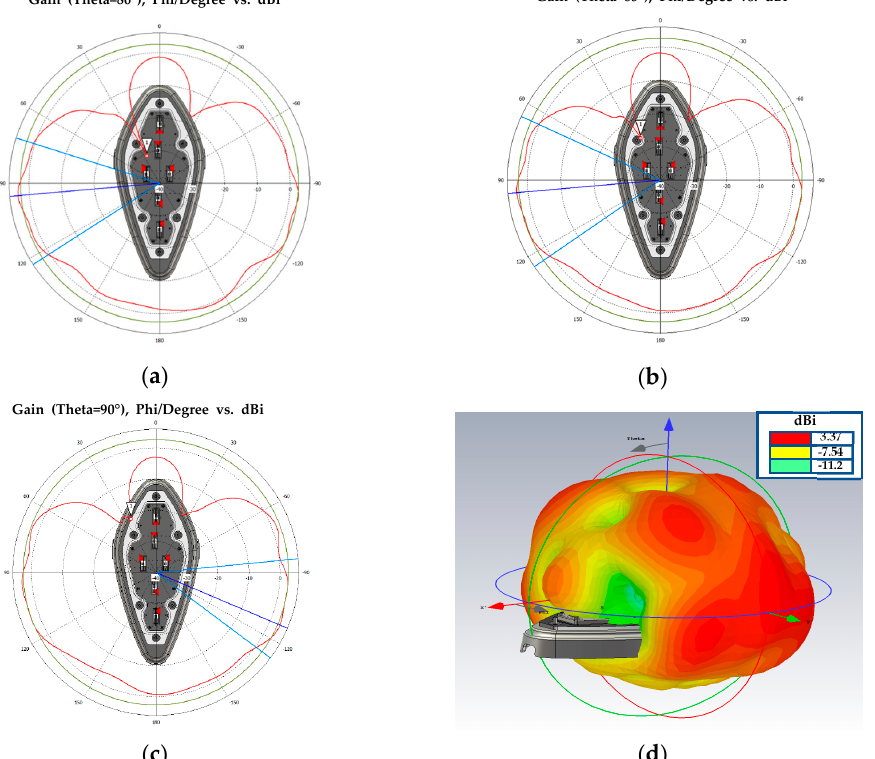
Figure 5. Radiated beam patterns obtained from the monopole-only WAVE antenna on the shark-fin module at the angles of ( a ) 80°, ( b ) 85°, and ( c ) 90°; and ( d ) 3D view. Conversely, the 2D- and 3D-radiated beam patterns from the monopole WAVE antenna with quadruple closed-loop devices on the shark-fin module (in Figure 1c) are shown in Figure 6. The 2D null value comparison of monopole-only (red color) and monopole with quadruple closed-loop devices (green color) at angles of 80°, 85°, and 90°, respectively, is shown in Figure 7a–c. At 80°, the null value is enhanced from − 30.8 to − 4.7 dBi. At 85°, the null value is enhanced from − 26 to − 5.5 dBi, and at 90°, the null value is enhanced from − 21 to − 6 dBi. From these simulation results, the monopole-only antenna has a serious null point when installed on the shark-fin module. However, the proposed antenna, a monopole with a closed-loop device, has an omnidirectional beam pattern without a null